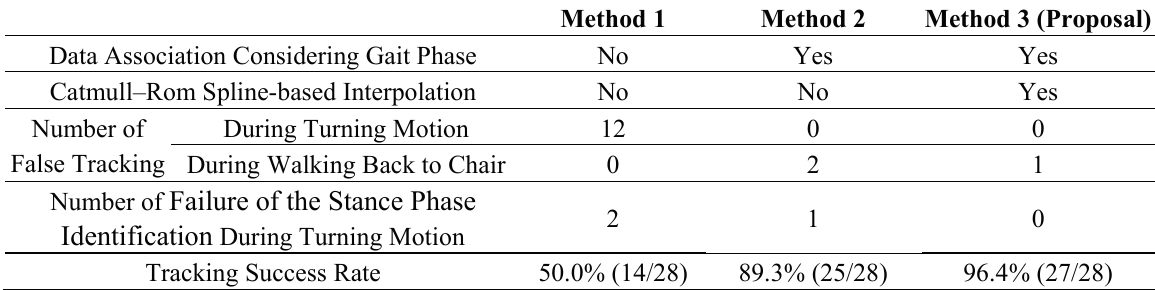
Table 3. Definitions and leg tracking results of each method of a total of 28 trials.